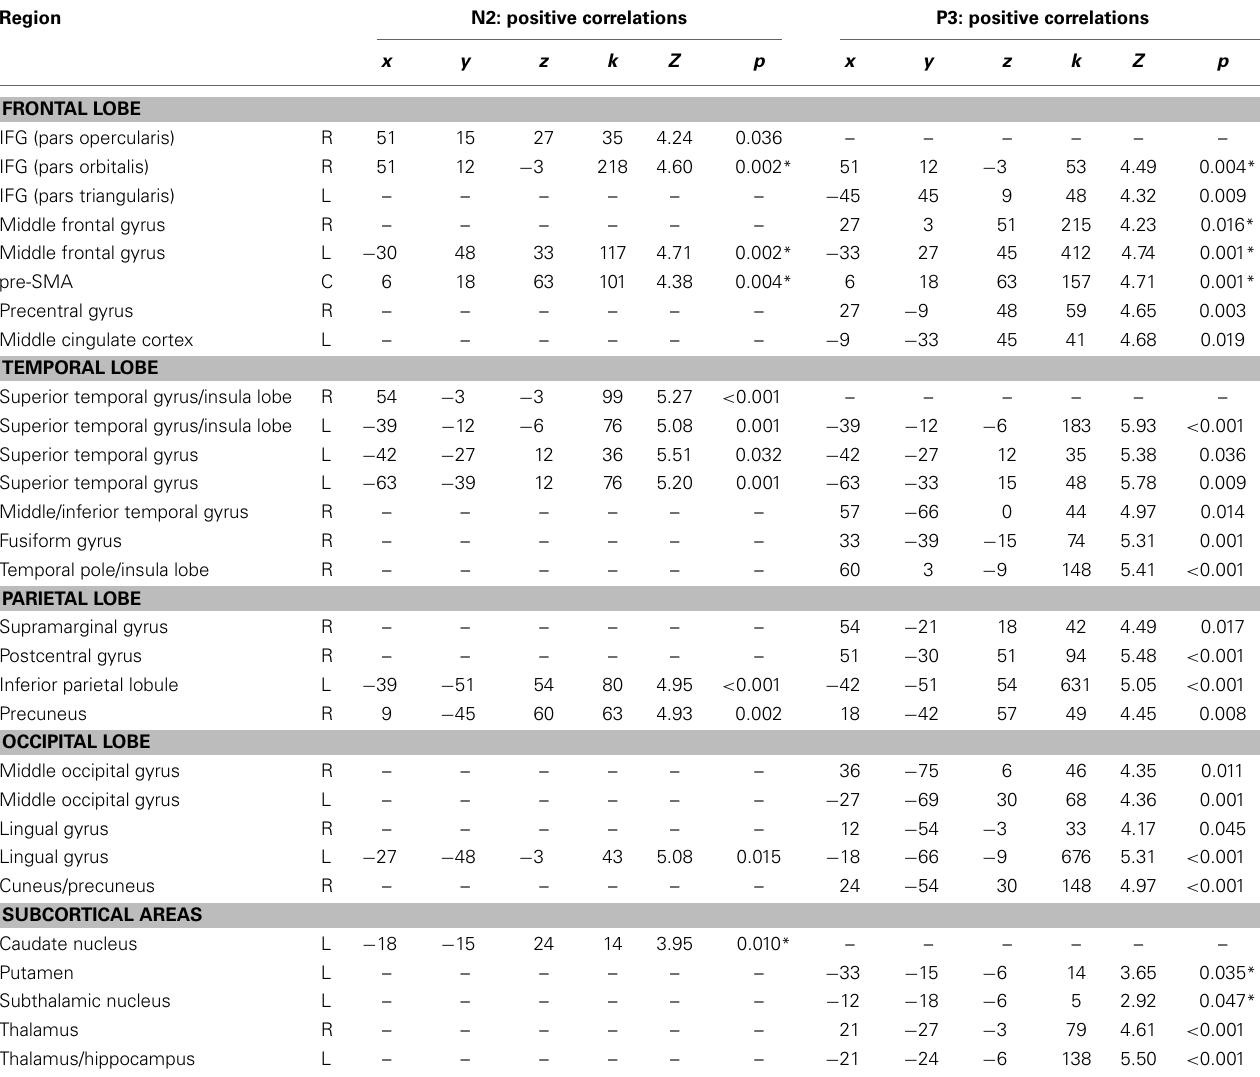
Table 2 | Positive correlations of fMRI BOLD signal with orthogonalized EEG-derived regressors N2 (280–340ms after stimulus onset), and P3 (350–570ms after stimulus